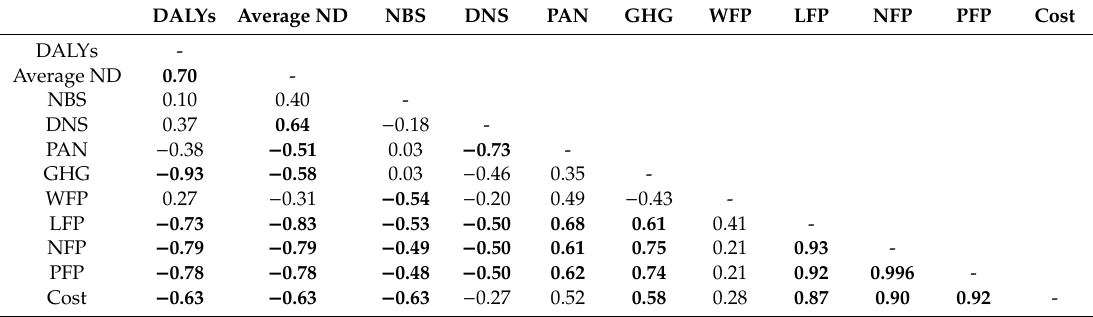
Table 5. Spearman rank correlation coe ffi cient ( ρ ) between di ff erent indicators of dietary sustainability used in this study. DALYs Average ND NBS